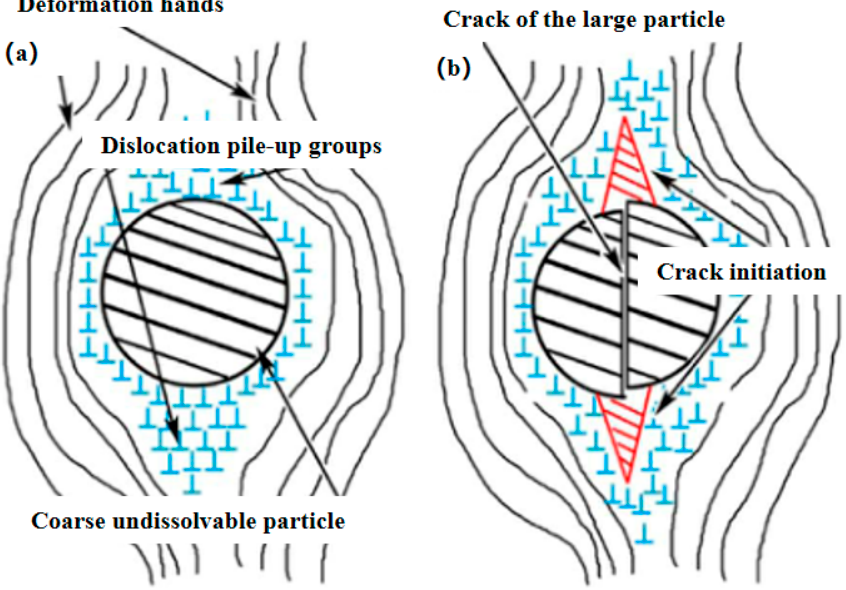
Figure 7. Schematic diagram of dislocation pile-up groups and crack initiation of large particles [37]. ( a ) dislocation pile-up groups ( b ) crack initiation. Materials 2022 , 15 , x FOR PEER REVIEW